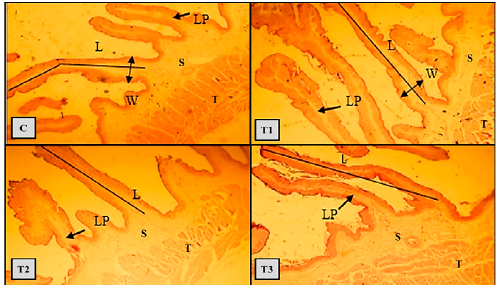
Figure 1. Histomorphology of lambs’ rumen during slaughter (the end of experiment) H&E, (×100). L = papilla height, W = width, LP = lamina propria, S = submucosa and T = tunica muscular. Treatments: C = barley and alfalfa hay were showing short and irregular papillae, lamina propria layer is wide with a mild thick layer of keratinized whereas, layers S and T were normal. T1 = TMR1 without PKM showed that L and W were within the norm, we could see regular papillae and formation of new structures. T2 = TMR2 with 20% PKC showed histological changes in the papillae structure, whereas T3 = T MR2 with 4 mL/ day drench with organic acids showed a clear improvement in the structure of the papillae.